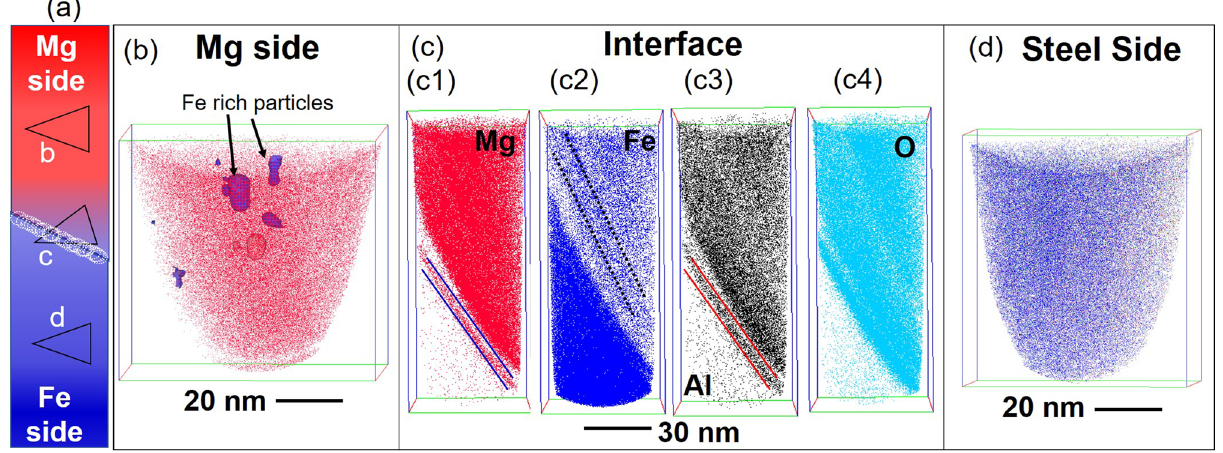
Figure 4. APT results from the interfacial region of the FaST joint between AZ31 and DP590. ( a ) schematic showing the region of interest for the APT analysis (notation b , c and d indicates corresponding figures) ; ( b ) reconstruction showing the Mg ion map from Mg alloy side; ( c ) reconstructions showing the Mg, Fe, Al, and O maps including the interface between the two alloys; ( d ) DP 590 steel side.